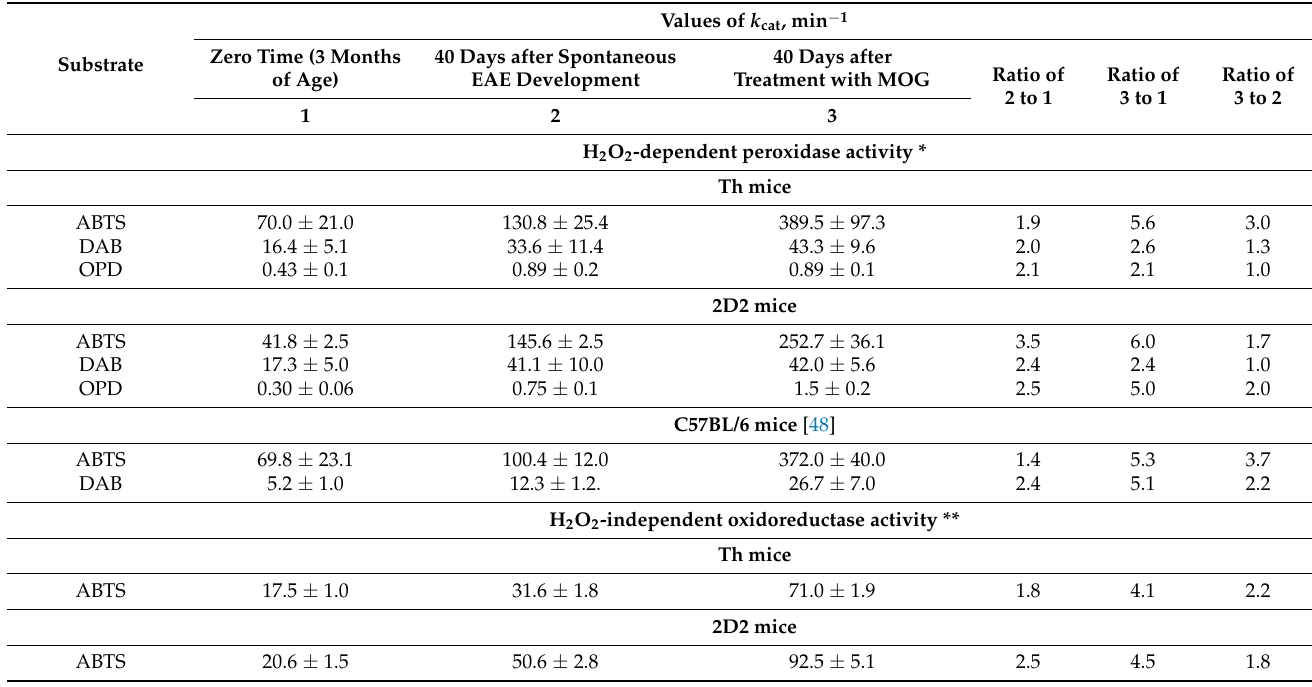
Table 1. Relative peroxidase and oxidoreductase activities IgGs of Th, 2D2, and C57BL/6 mice. Values of k cat , min − Substrate